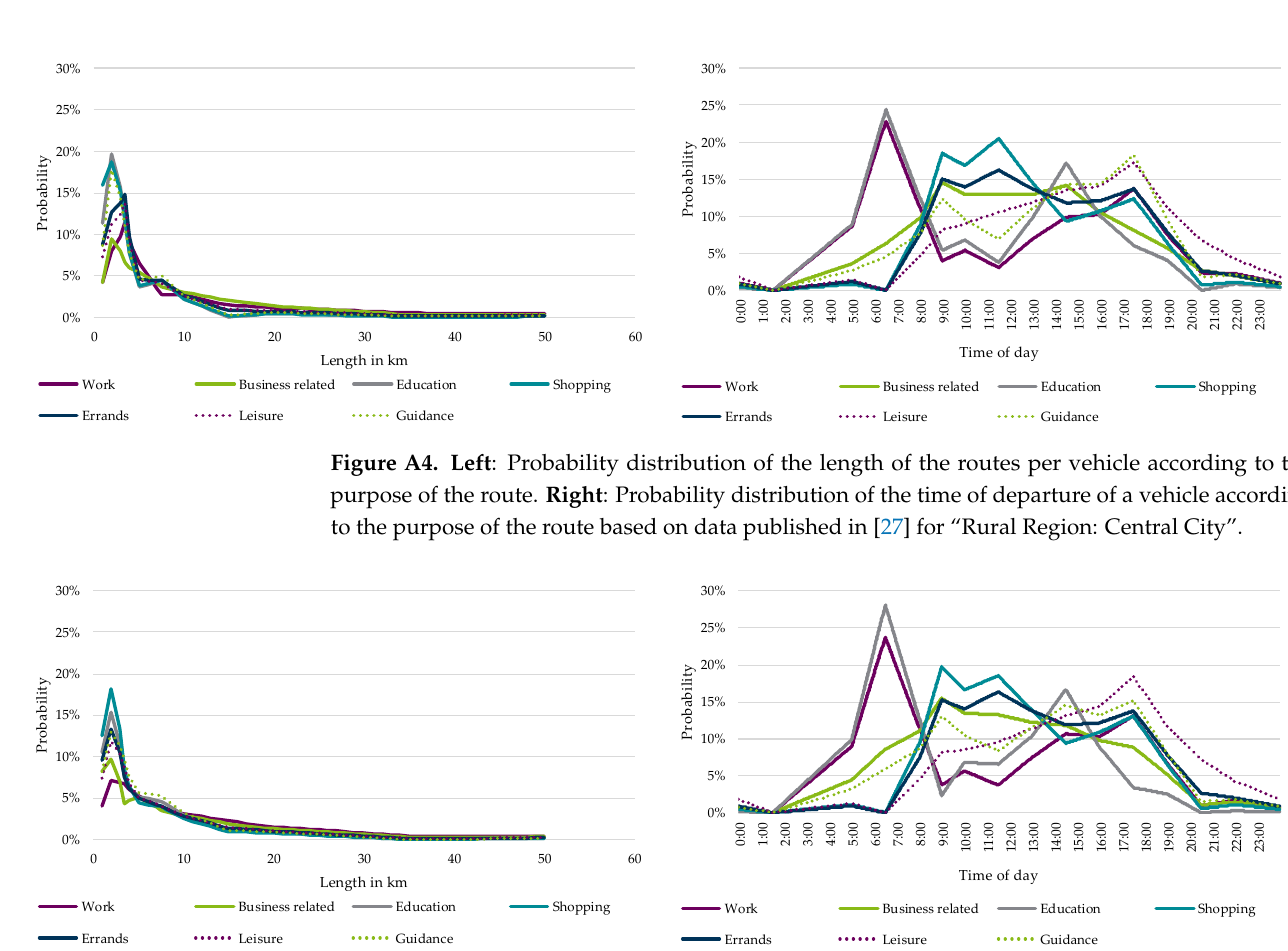
Figure A5. Left : Probability distribution of the length of the routes per vehicle according to the purpose of the route. Right : Probability distribution of the time of departure of a vehicle according to the purpose of the route based on data published in [27] for “Rural Region: Medium-sized City, Urbanised Area”.